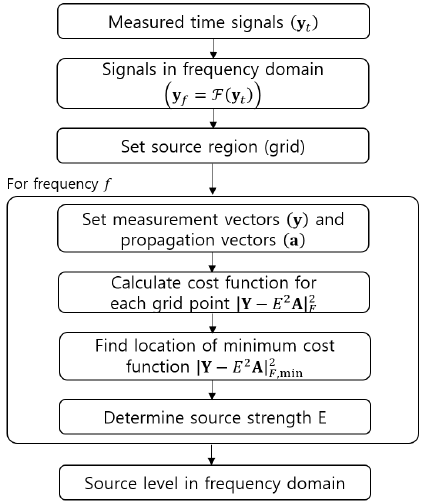
Figure 2. Procedure of the source-level estimation.